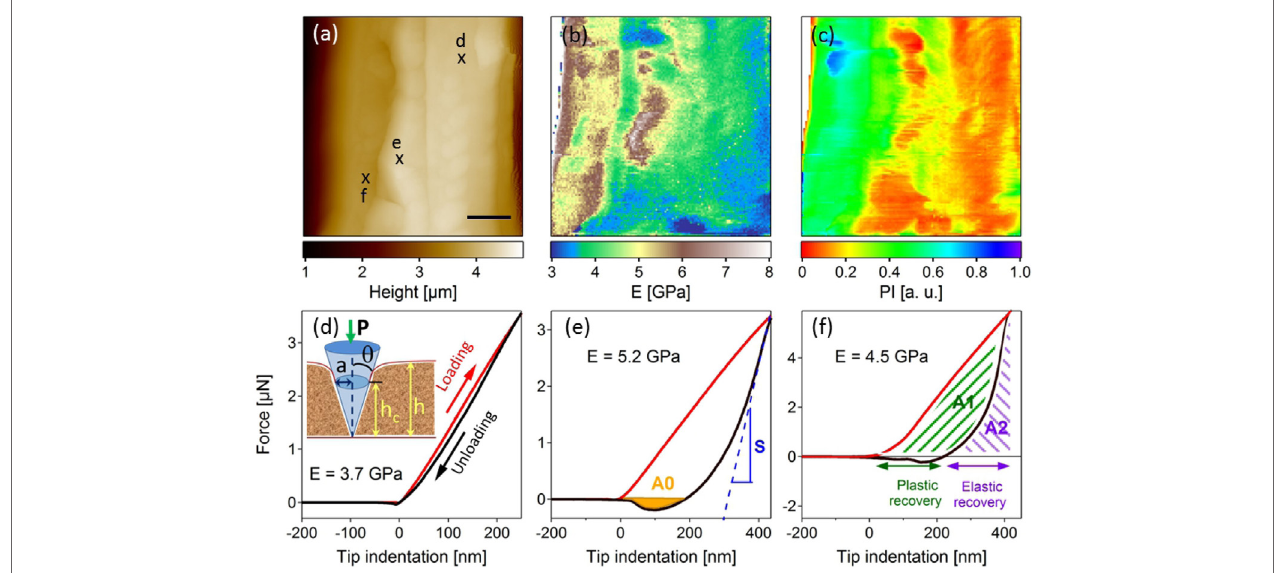
FiGURe 3 | Topographic (A) and associated mechanical imaging (B,C) (Young’s modulus (e) and plastic index (PI) mappings) (scale bar 1 µm) obtained on an untreated raw poplar cell wall. (D–F) Discrete force curves extracted at the marked localizations on the topographic image (A) . Red and black curves correspond to the loading and unloading during tip indentation [inset (D) ], respectively. (D) gives an illustration of elastic behavior and (e) of plasticity with adhesion (A0). S, the slope obtained by fitting the beginning of the unloading curve, is used to calculate the Young’s modulus. A1 and A2 in (F) are two parameters used to access the plasticity index. Data from Farahi et al. (2017),